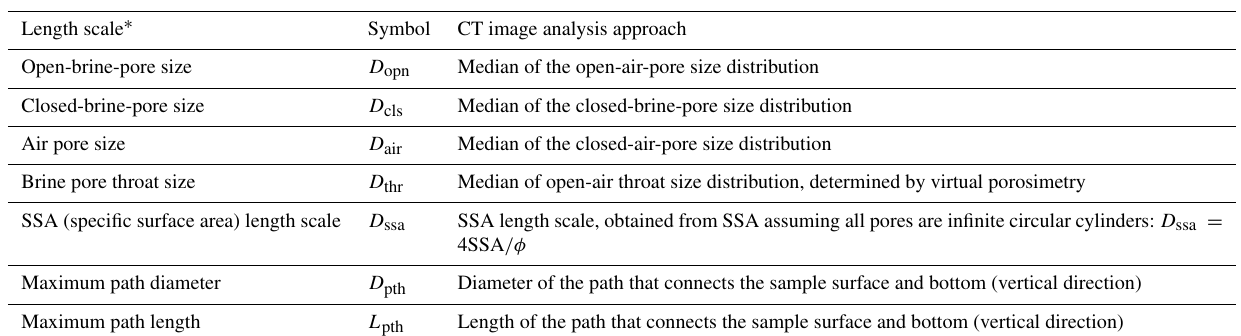
Table 2. Characteristic pore